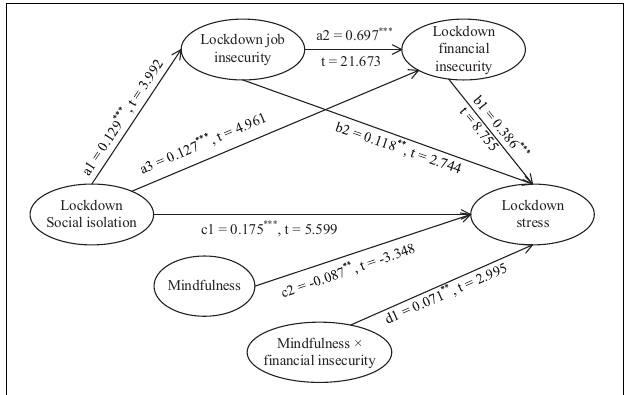
FIGURE 2 | A graphical illustration of parameter estimates. [* p < 0.05, ** p < 0.01, and *** p < 0.001. Number of free parameters = 60, Loglikelihood (LL) = − 25741.958, AIC = 51603.916, N = 1356. Note: When using the LMS method, Mplus does not produce indices of model fit like CFI and TLI, but